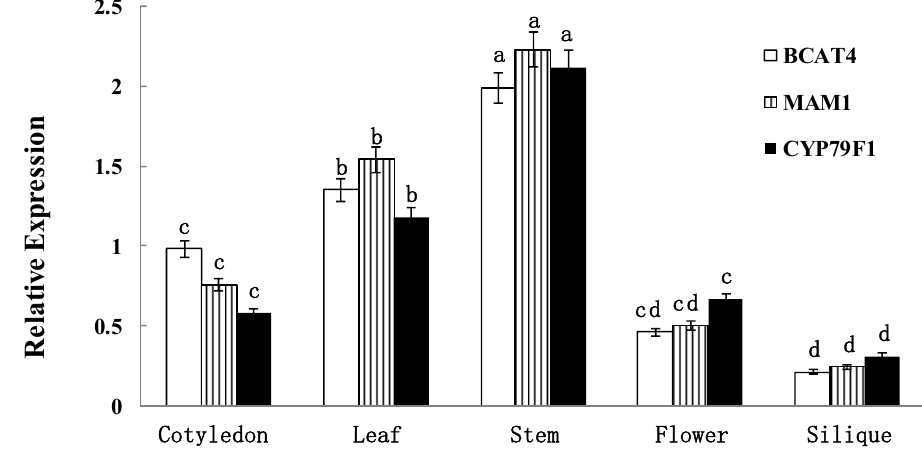
Figure 2. Spatial expression patterns of BCAT4 , MAM1 and CYP79F1 . The tissues are defied as: cotyledon (7 days), leaf (15 days), stem (30 days), flower (anthesis) and silique (15 days post-anthesis). Each bar represents the mean (±standard error) of three independent biological replicates. Different letters on the top indicate significant differences at p < 0.05.